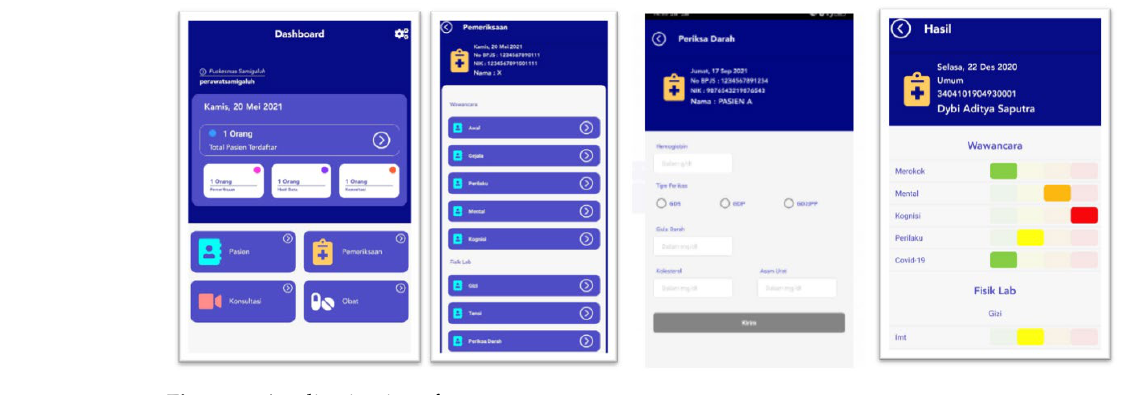
Figure 2. Application interface.